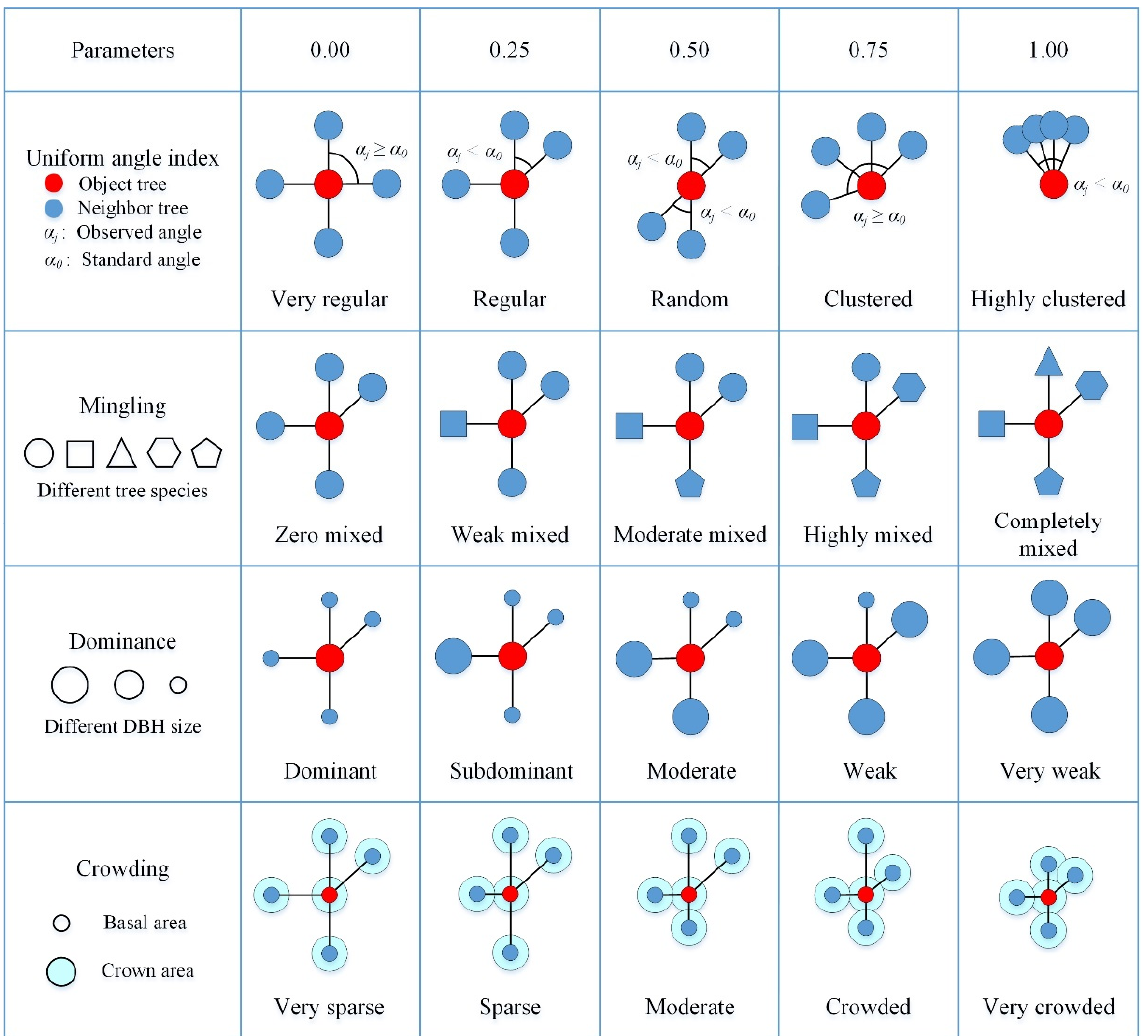
Figure 2. Schematic diagram of four stand spatial structural parameters. The Uniform angle index compared the size of observed angle α j formed by two nearest neighbors and the reference tree to the standard angle α 0 (72°); the Mingling, Dominance and Crowding compared whether the tree species are the same, the size of DBH and whether the crowns overlap between the reference tree and its four neighboring trees, respectively.